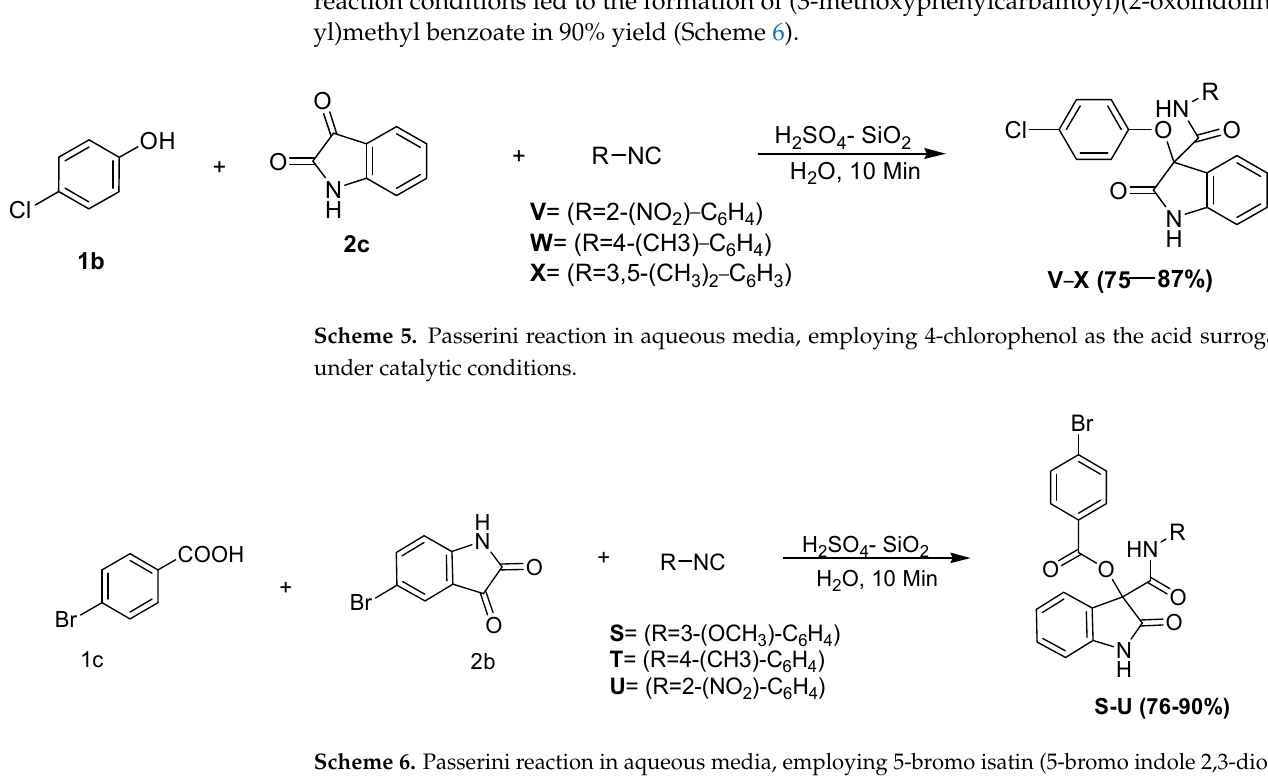
Table 3. Efficiency of the recycled catalyst in the model Passerini reaction.